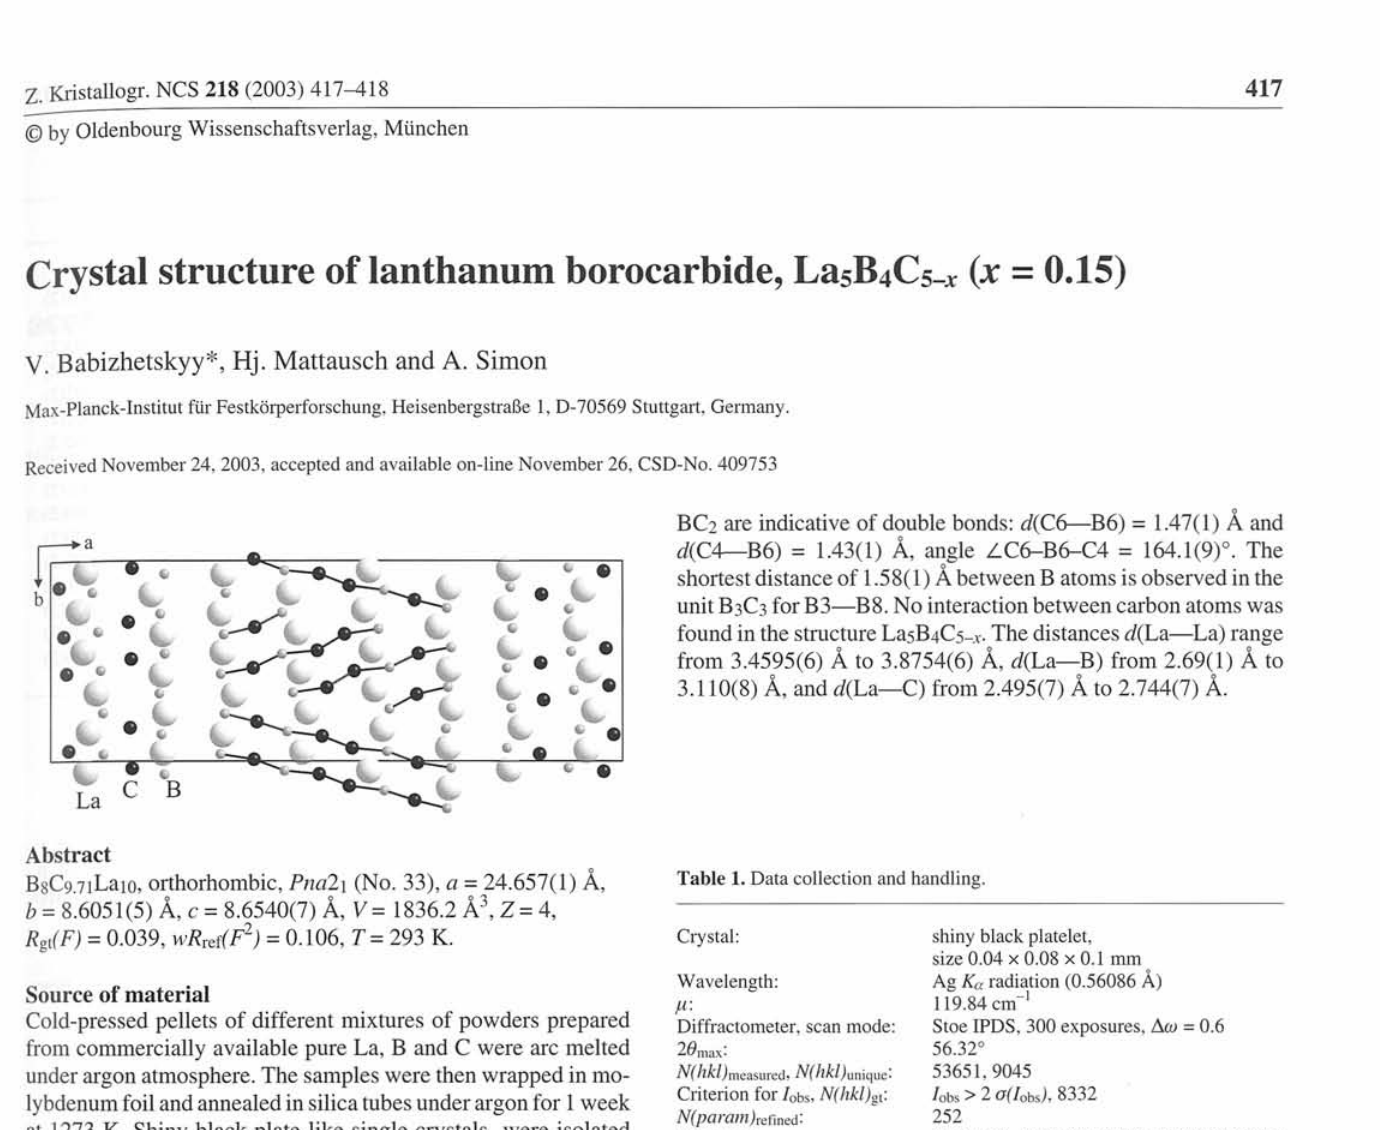
Table 3. Atomic coordinates and displacement parameters (in Á ?